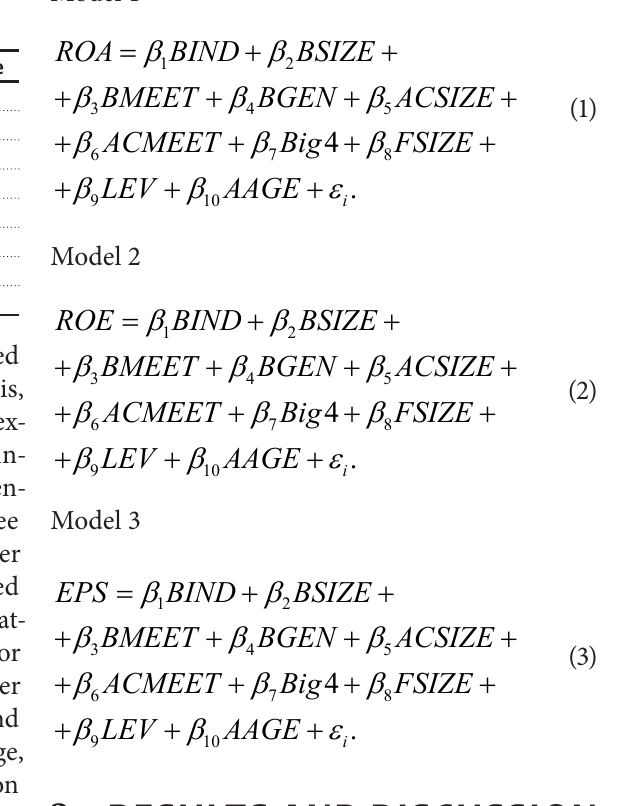
Table 1. Descriptive statistics for the type